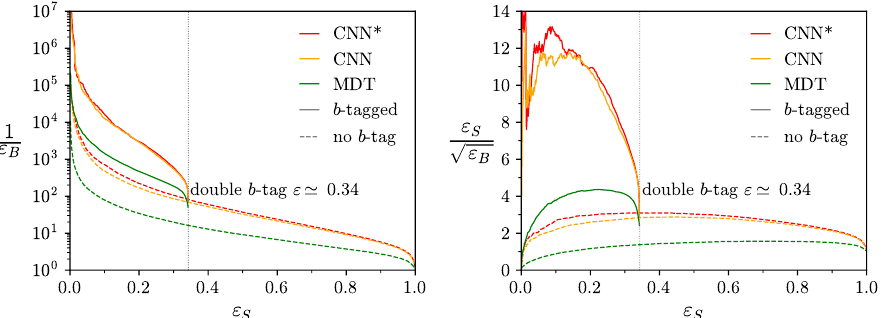
Figure 11. Left panel: receiver operating characteristic (ROC) curves. Right panel: significance improvement characteristic (SIC)